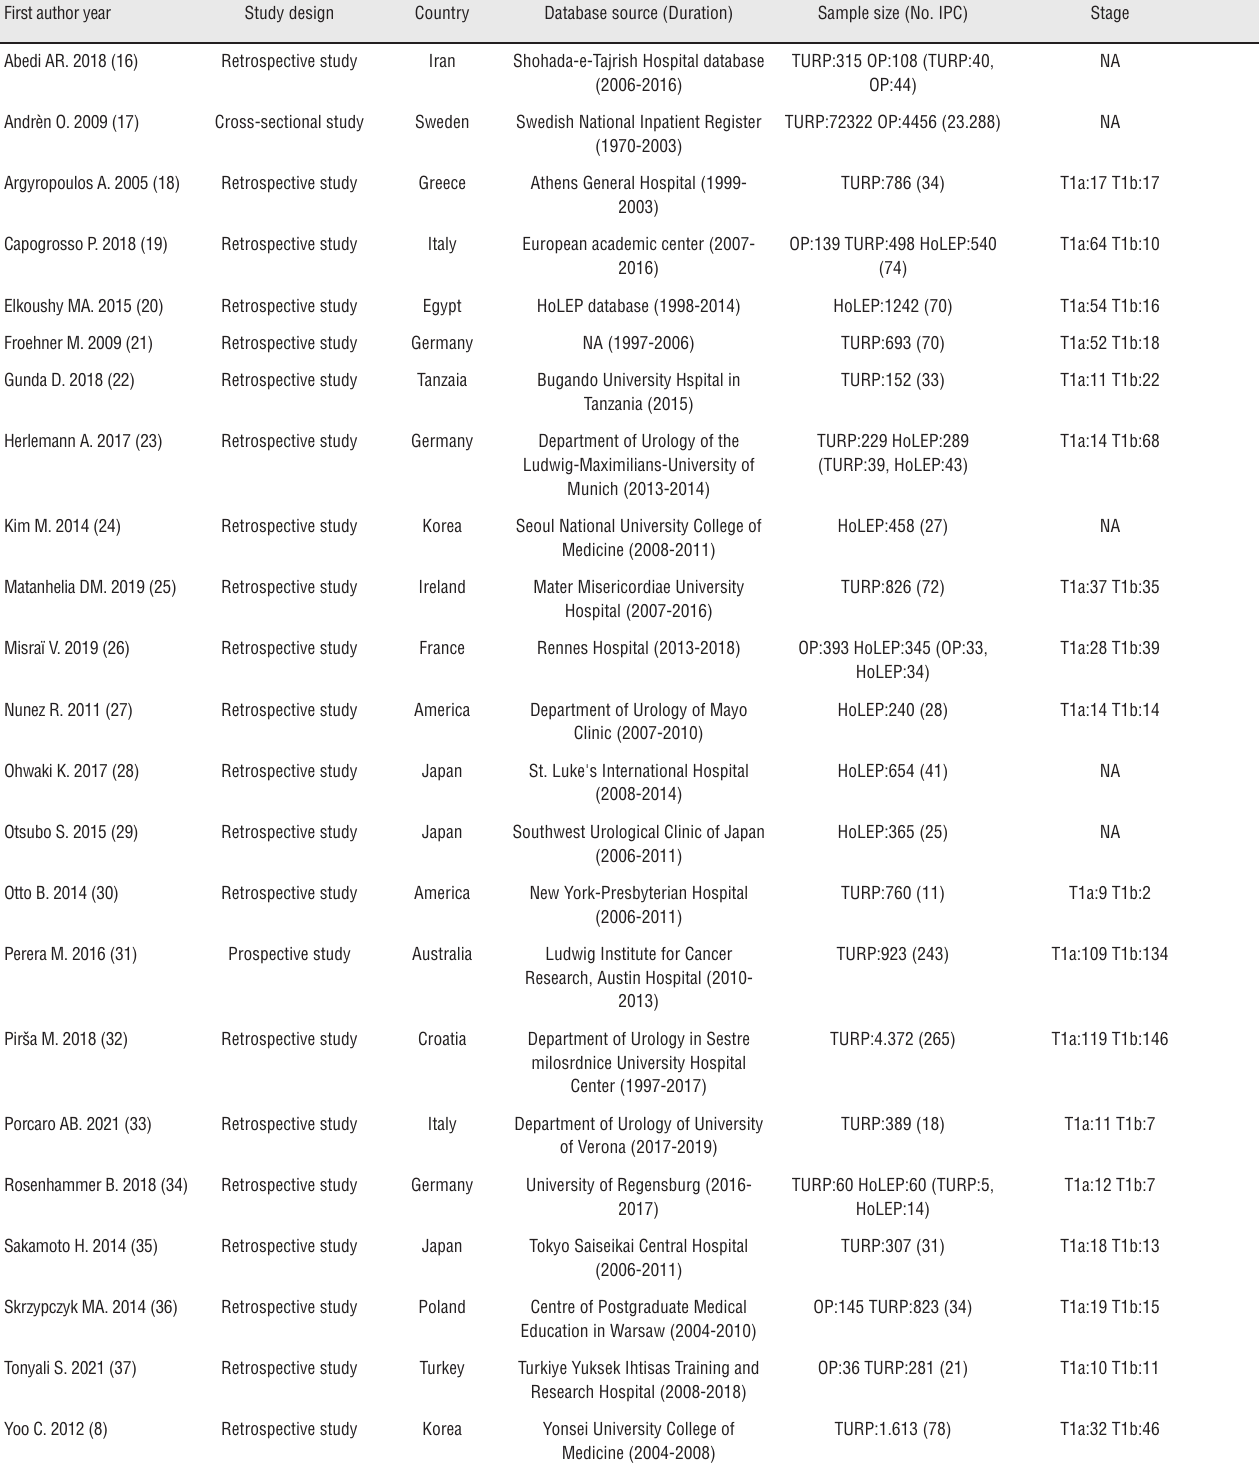
Table 1 - Characteristics of the included